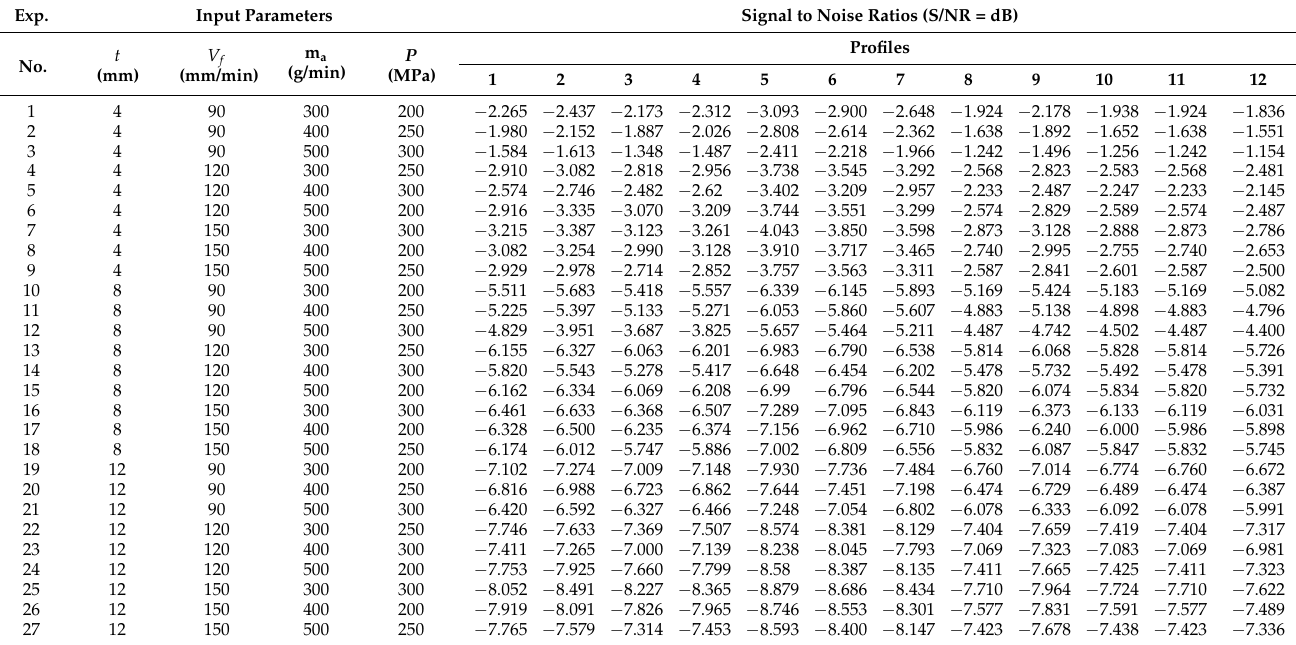
Table A1. Signal-to-noise ratios for surface roughness (smaller is better). Exp.